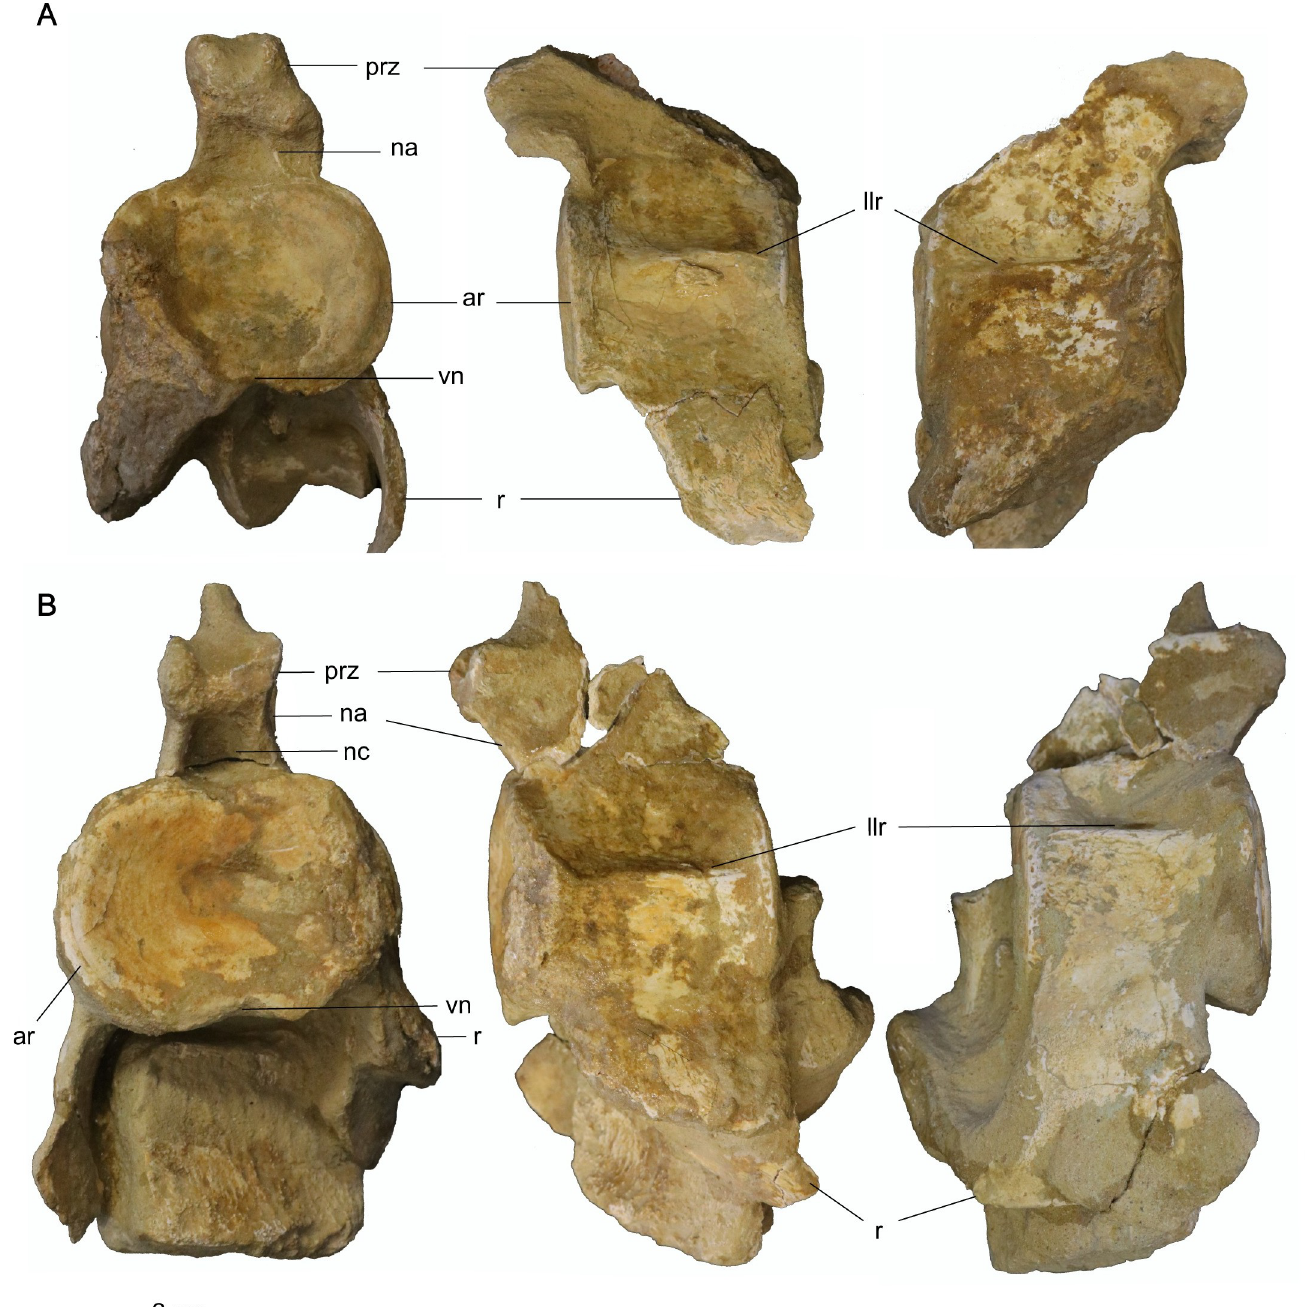
Fig 20. Middle cervical vertebrae a and b of Cardiocorax mukulu (MGUAN PA278). A. Anterior, left lateral, and right lateral view of ‘middle cervical vertebra a’ from Cardiocorax mukulu (MGUAN PA278). B. Anterior, left lateral, and right lateral view of ‘middle cervical vertebra b’ from Cardiocorax mukulu (MGUAN